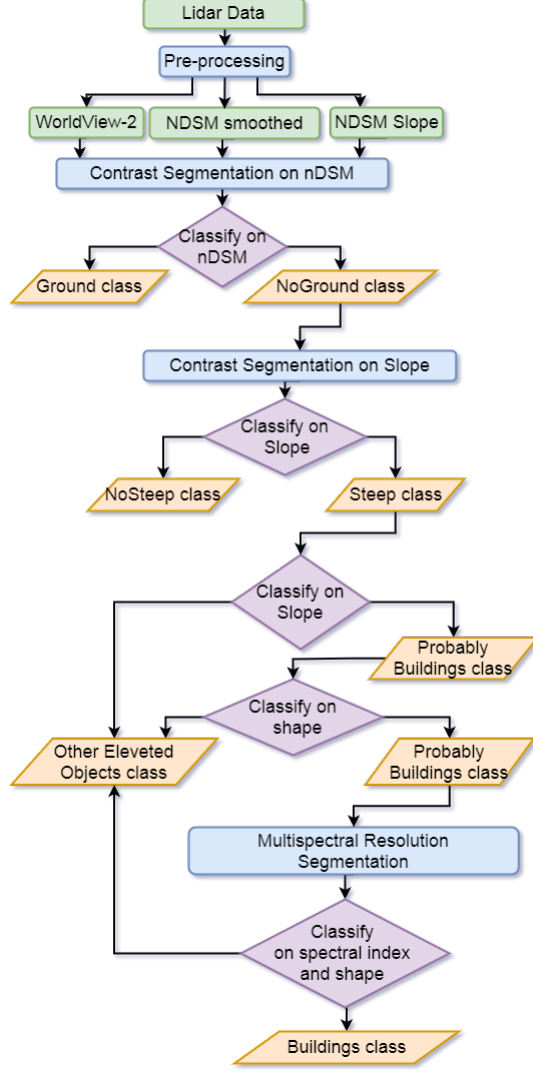
Figure 2. Workflow of the developed rule-based classification